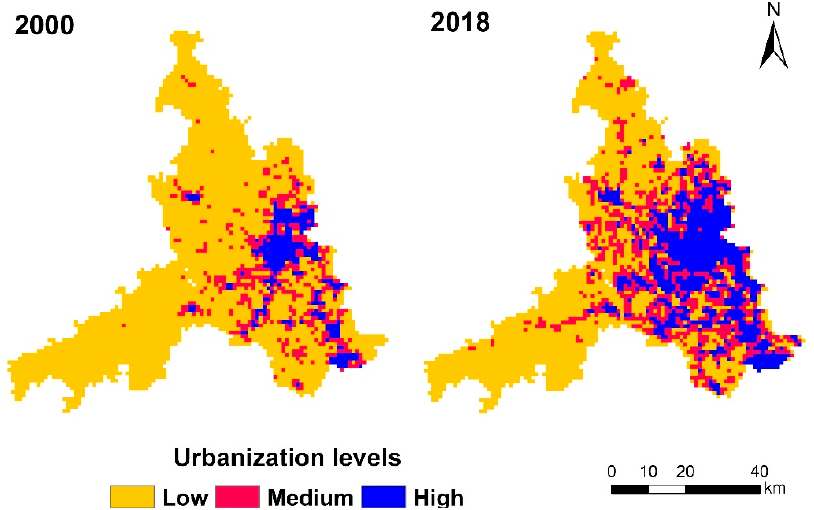
Figure 4. Spatial distribution of urbanization levels in Foshan in 2000 and 2018 based on comprehensive urban development indicators.